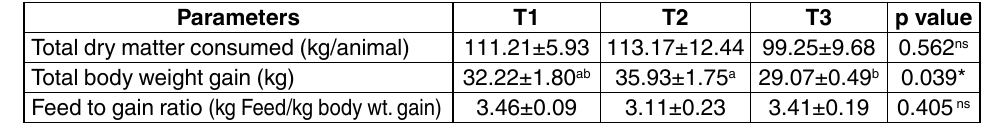
table 5. Mean feed conversion ratio 1 of the calves maintained on the three experimental rations, kg Parameters t1 t2 Total dry matter consumed